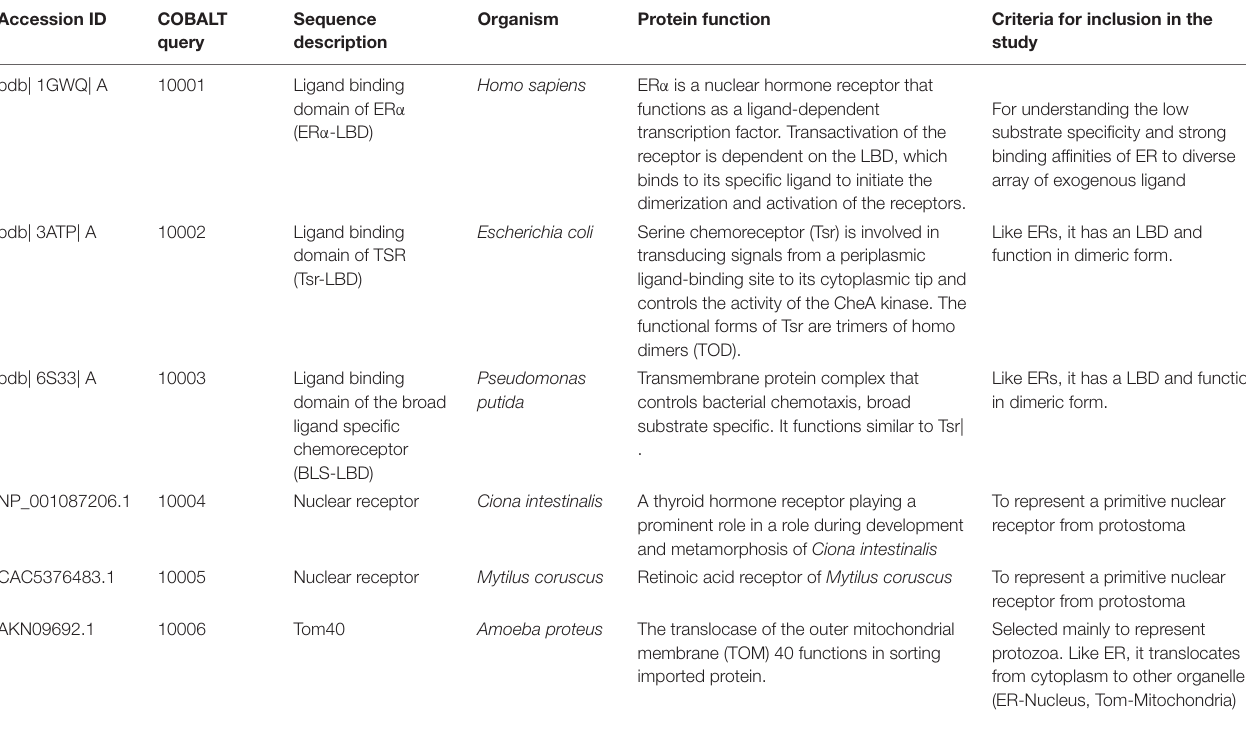
TABLE 1 | Sequence ID and the function for the sequences selected for COBALT